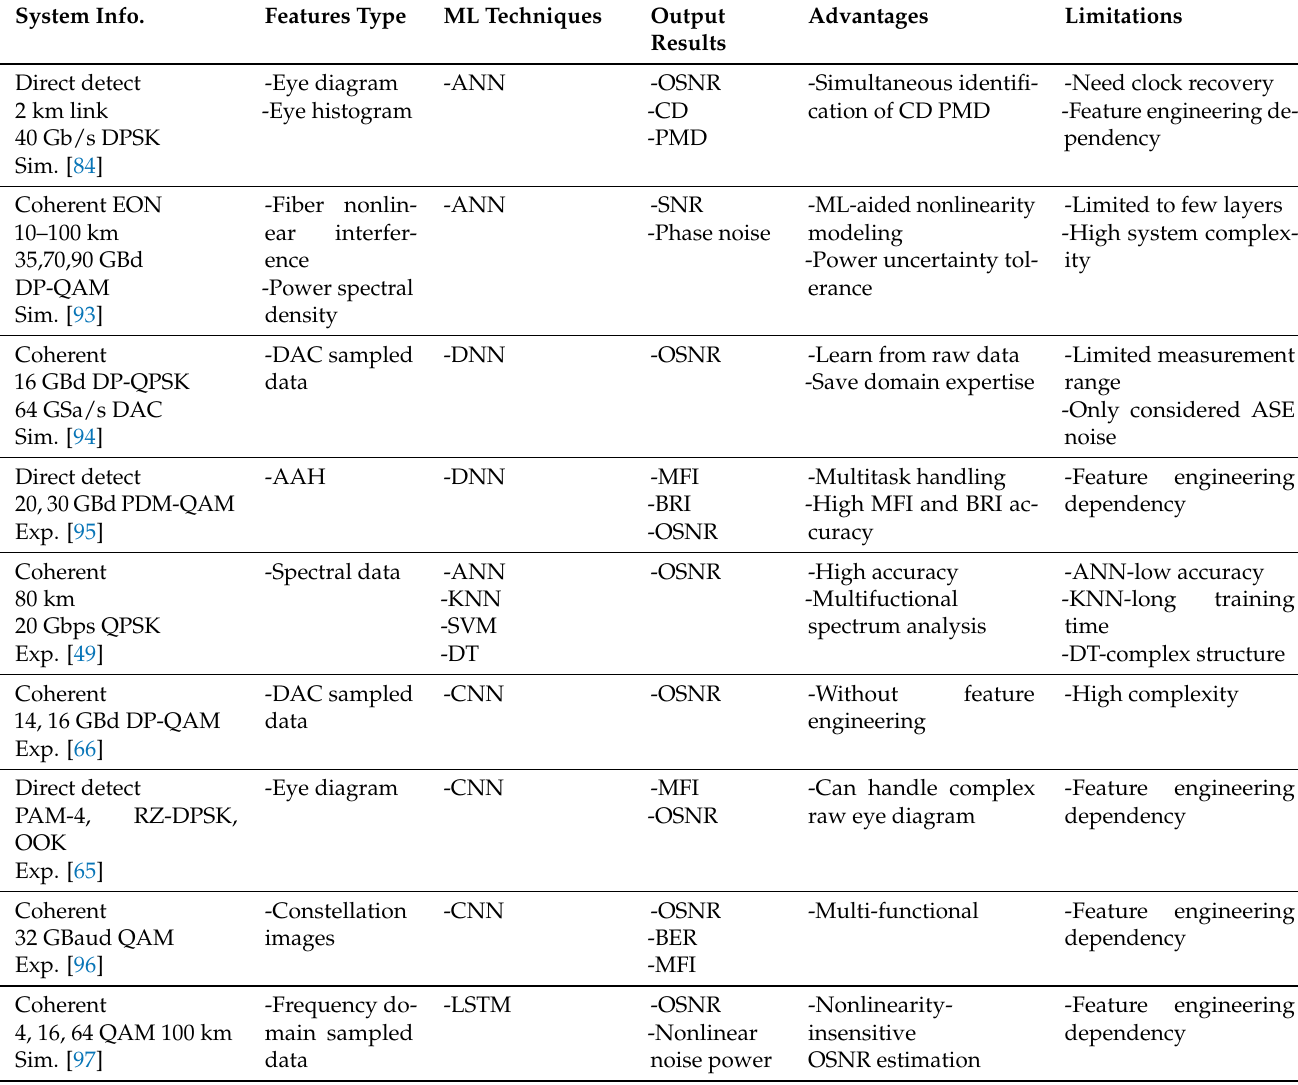
Table 1. OPM and MFI applications based on machine